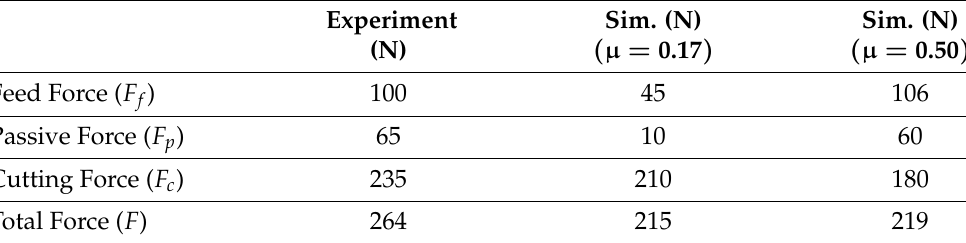
Table 7. Comparison of simulated (Sim.) cutting force with different friction coefficients ( µ ) vs. experimental